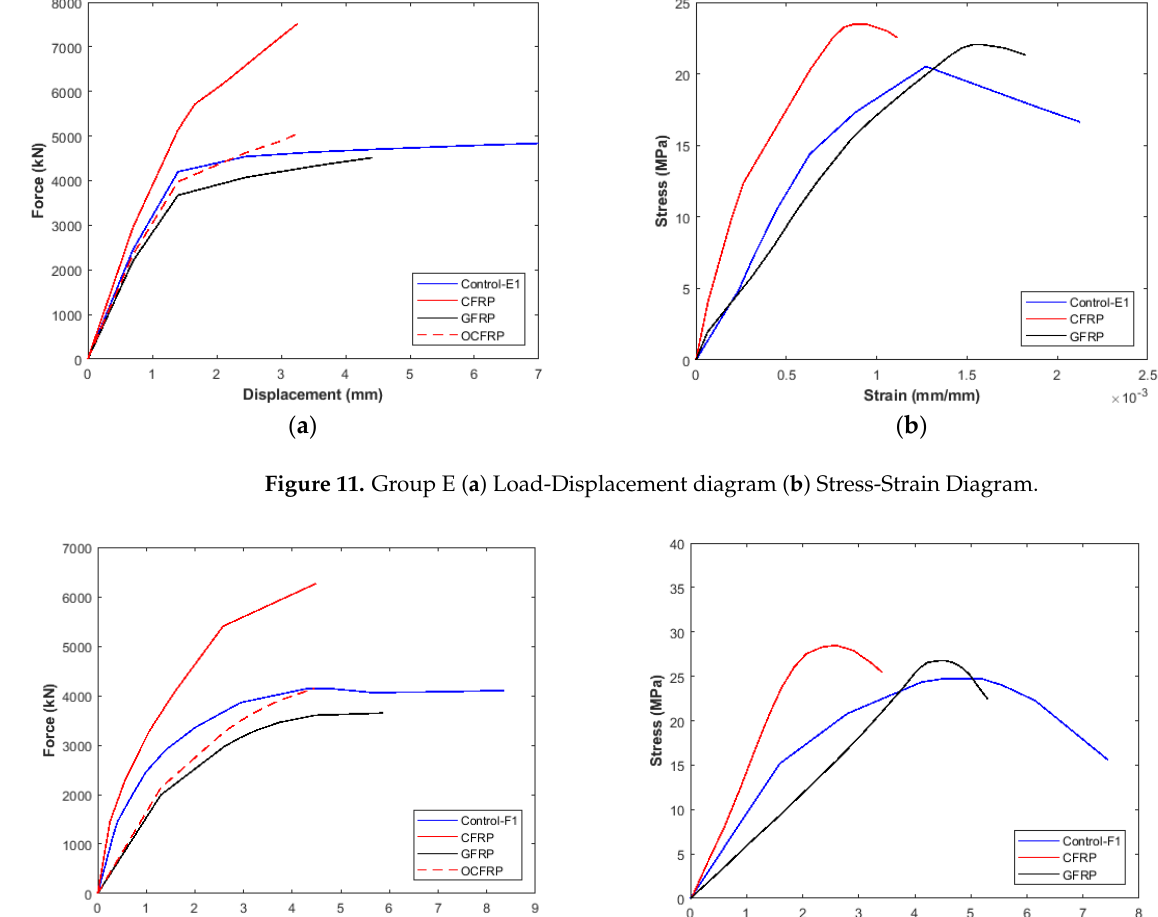
Figure 10. Group D ( a ) Load-Displacement diagram ( b ) Stress-Strain Diagram.